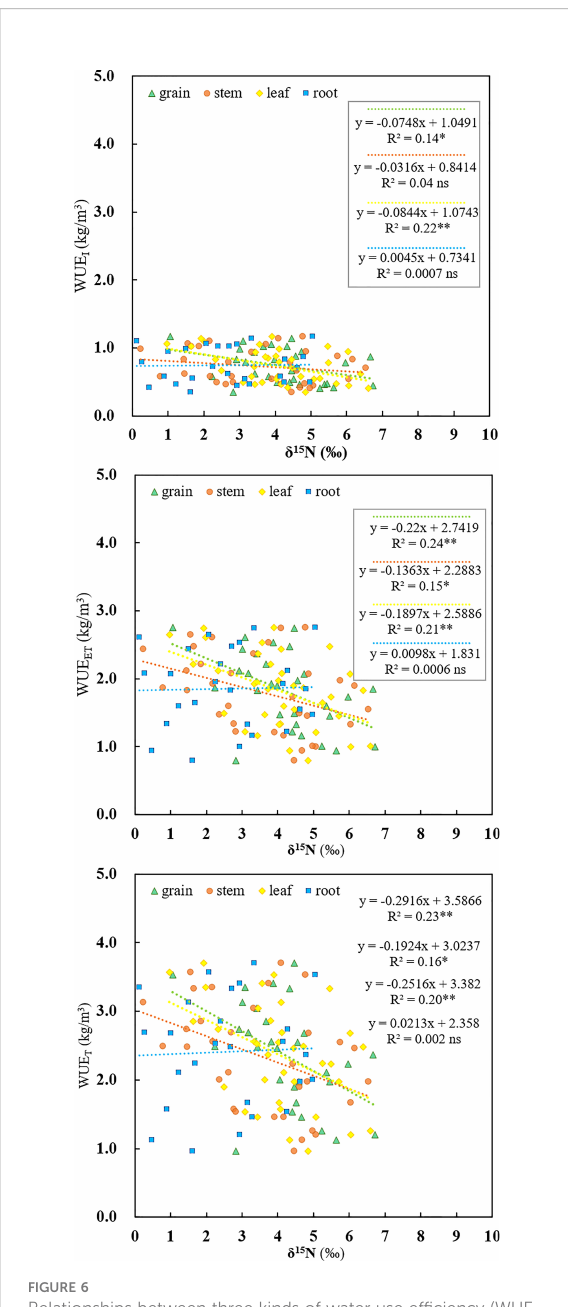
FIGURE 6 Relationships between three kinds of water use ef fi ciency (WUE I , WUE ET , WUE T ) and nitrogen isotope composition of diverse rice organs ( d 15 N grain , d 15 N stem , d 15 N leaf , d 15 N root ) as in fl uenced by different water regimes and soil clay contents. ns, *, ** and represent no signi fi cance, 0.01< p <0.05, and p <0.01,